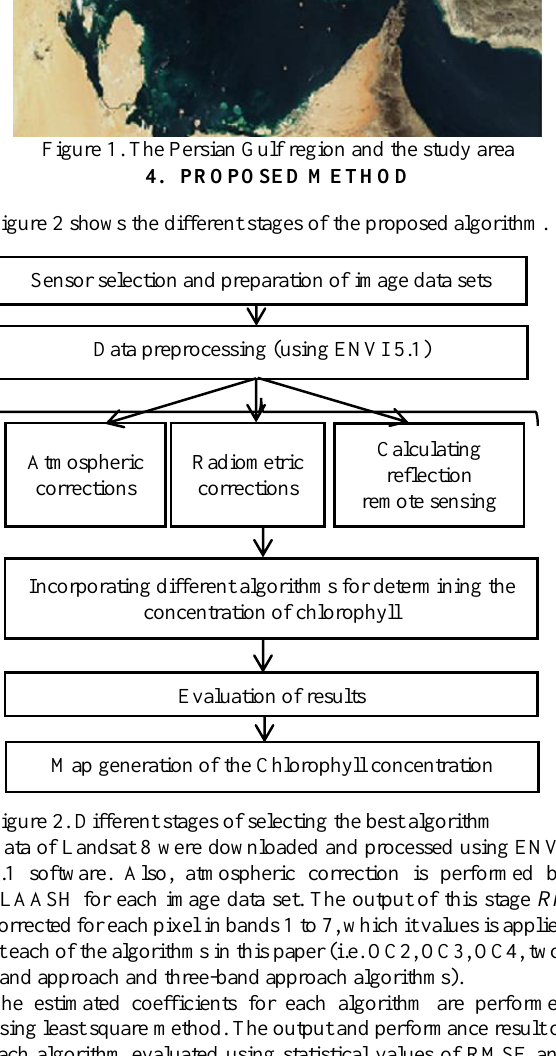
Figure 3. The remaining graph of different